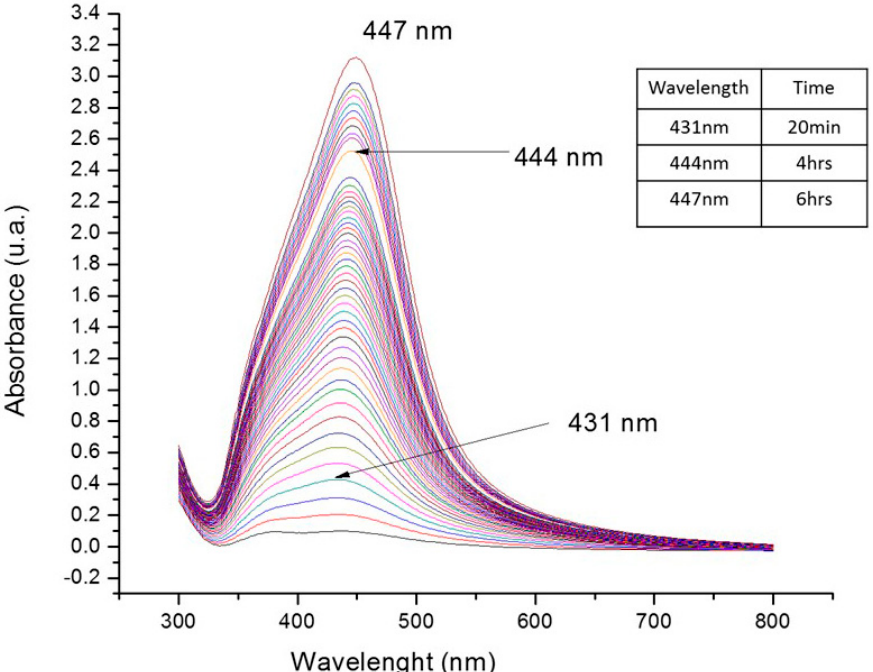
Figure 1. UV-Vis absorption spectrum of synthesized silver nanoparticles by S. aromaticum extract at different time intervals.